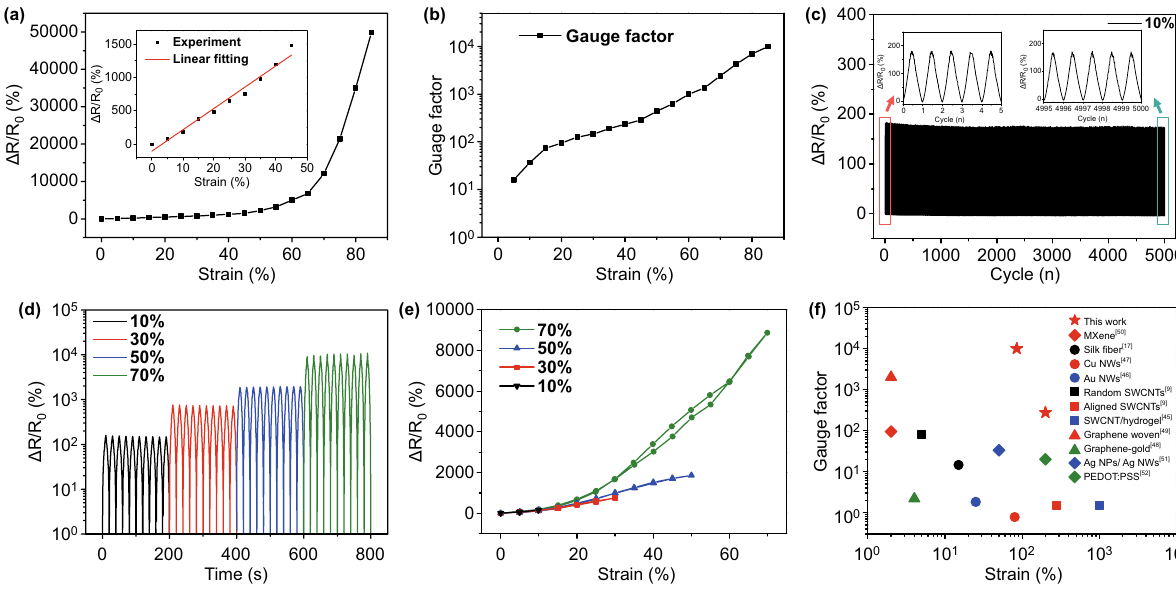
Fig. 3 Sensing properties of CNT-based strain sensors. a Relative resistance response of CNT-based strain sensors versus applied strain. b Gauge factor of CNT-based strain sensors versus applied strain. c Relative resistance change versus applied strain over 5000 cycles. d Relative resistance change versus applied strain with increasing maximum strain from 10% to 70%. e Hysteresis curves of the stretch/release cycles under different maximum applied strain. f Comparison on gauge factor (GF) and maximum strain between our strain sensors and the recently reported strain sensors, which constructed by different conductive materials, including MXene [50], Silk fiber [17], Cu Nanowires (NWs) mesh [47], Au NWs [46], Single-walled carbon nanotubes (SWCNTs) [9], SWCNT/hydrogel [45], graphene woven microfabrics [49], graphene-gold mesh [48], Ag Nanoparticles (NPs)/Ag NWs [51] and PEDOT:PSS